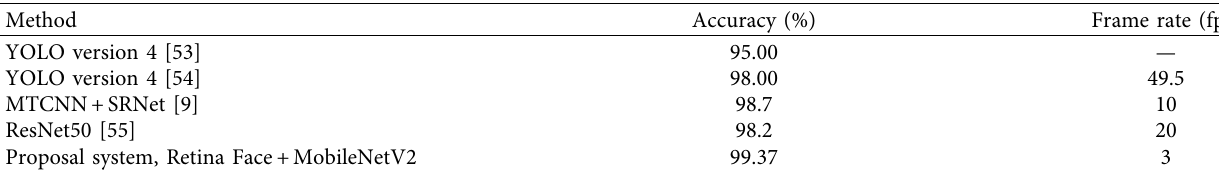
Figure 22: Result of (a) accuracy and (b) loss of a model. Table 4: Comparing with the system [9].